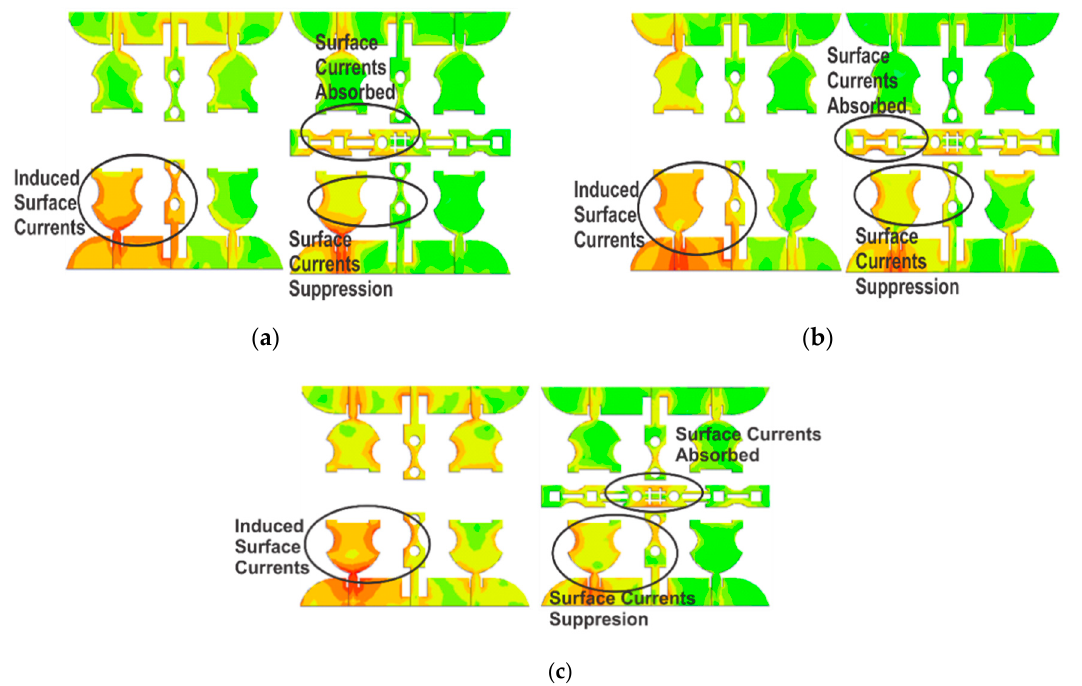
Figure 5. Surface current distribution of UWB-MIMO antenna: ( a ) 4 GHz; ( b ) 6 GHz; ( c ) 10 GHz.